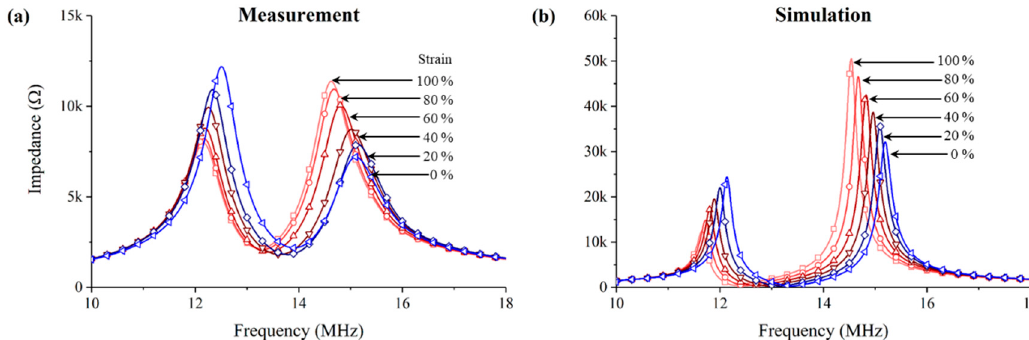
Figure 8. Experimentally measured and simulated impedance magnitudes of the transceiver at 10 mm away from the sensor. The frequency of the right peak was shifted ( a ) from 15.01 MHz at 0% strain to 14.59 MHz at 100% strain in experiment, and ( b ) from 15.31 MHz at 0% strain to 14.47 MHz at 100% strain in simulation.